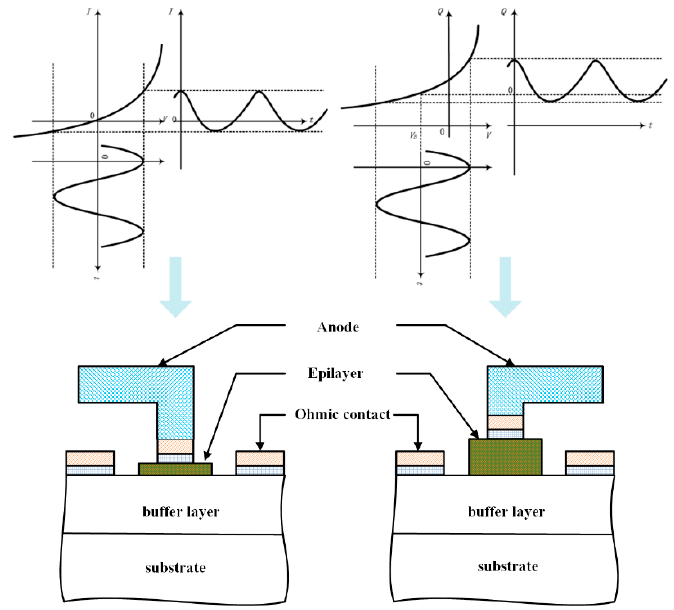
Figure 2. Structures and operating principles of the Schottky varistor and varactor.